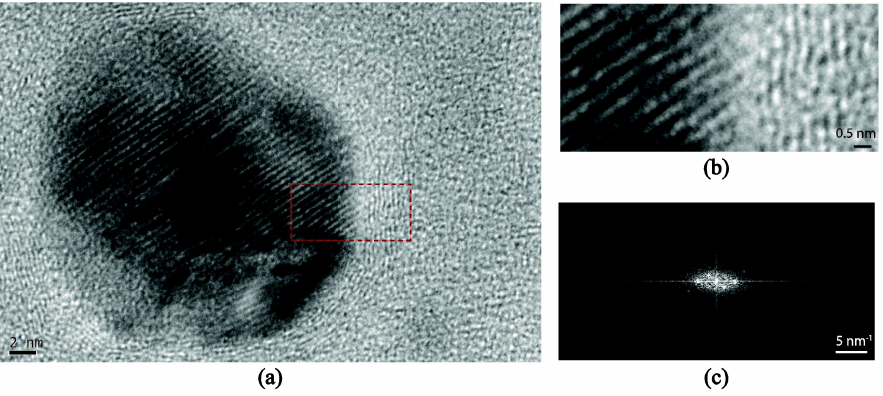
Figure 6. ( a ) High resolution TEM image of a Ti nanoparticle with the surrounding a–C:H matrix; ( b ) A magnified view of the a–C:H/Ti interface showing the transition in crystalline domains; ( c ) 2D FFT of image selection, identifying the two dominant